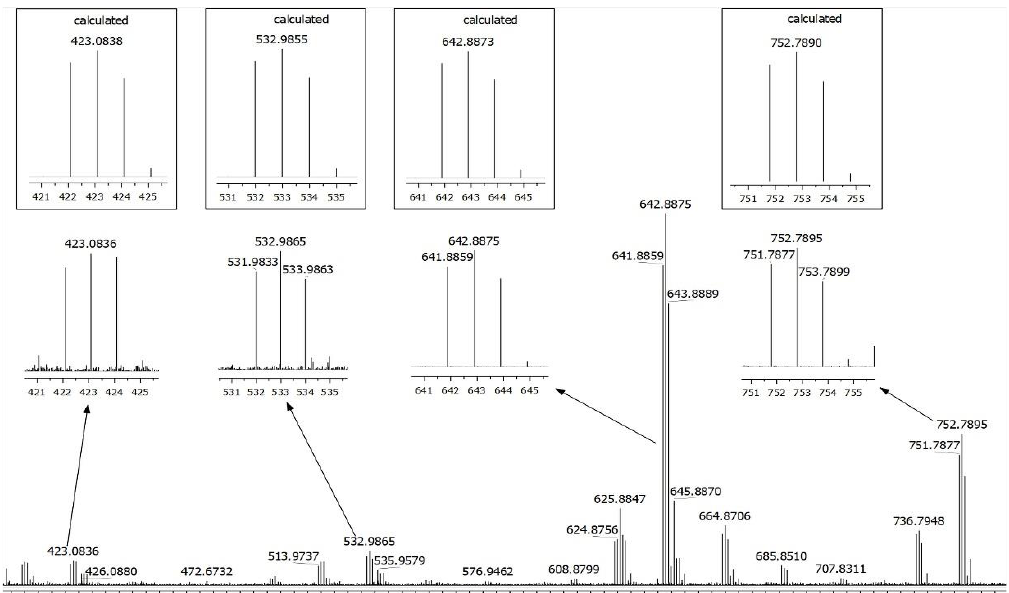
Figure 6. EIS(+)-MS spectrum of 1A (1 mg/L in H 2 O at pH = 7.4 (by adding